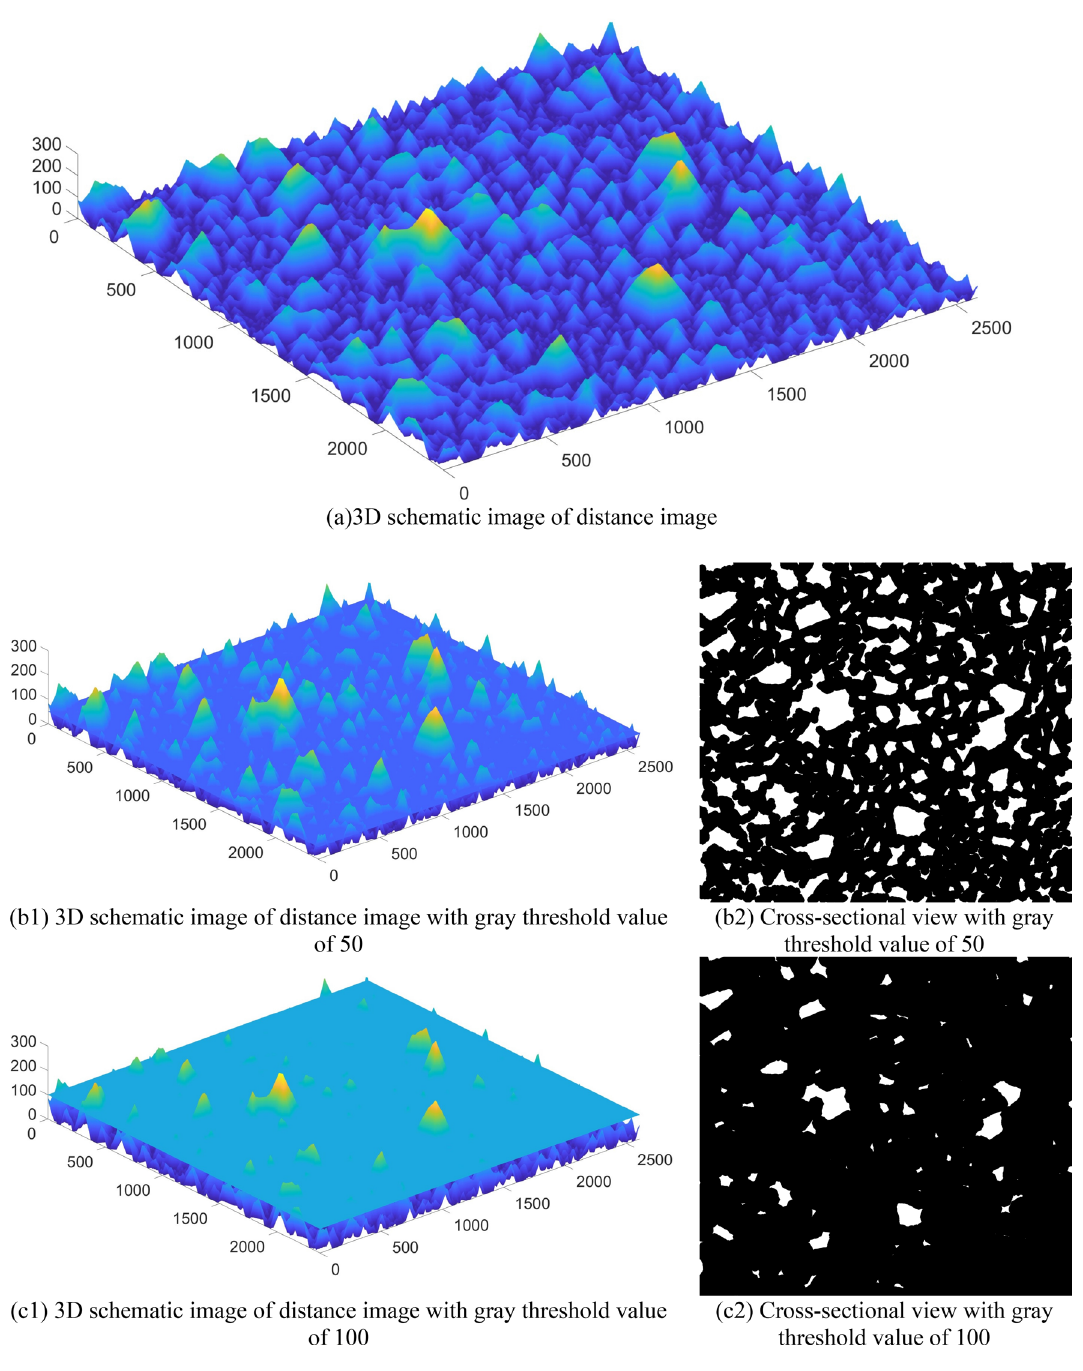
Figure 13. 3D schematic image of distance image and 2D cross-sectional image under different gray